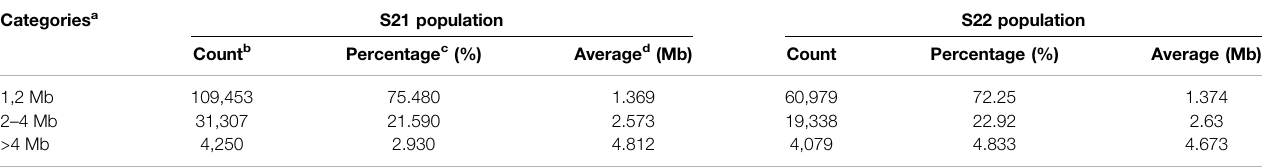
TABLE 1 | Number, percentage, and average length for ROHet